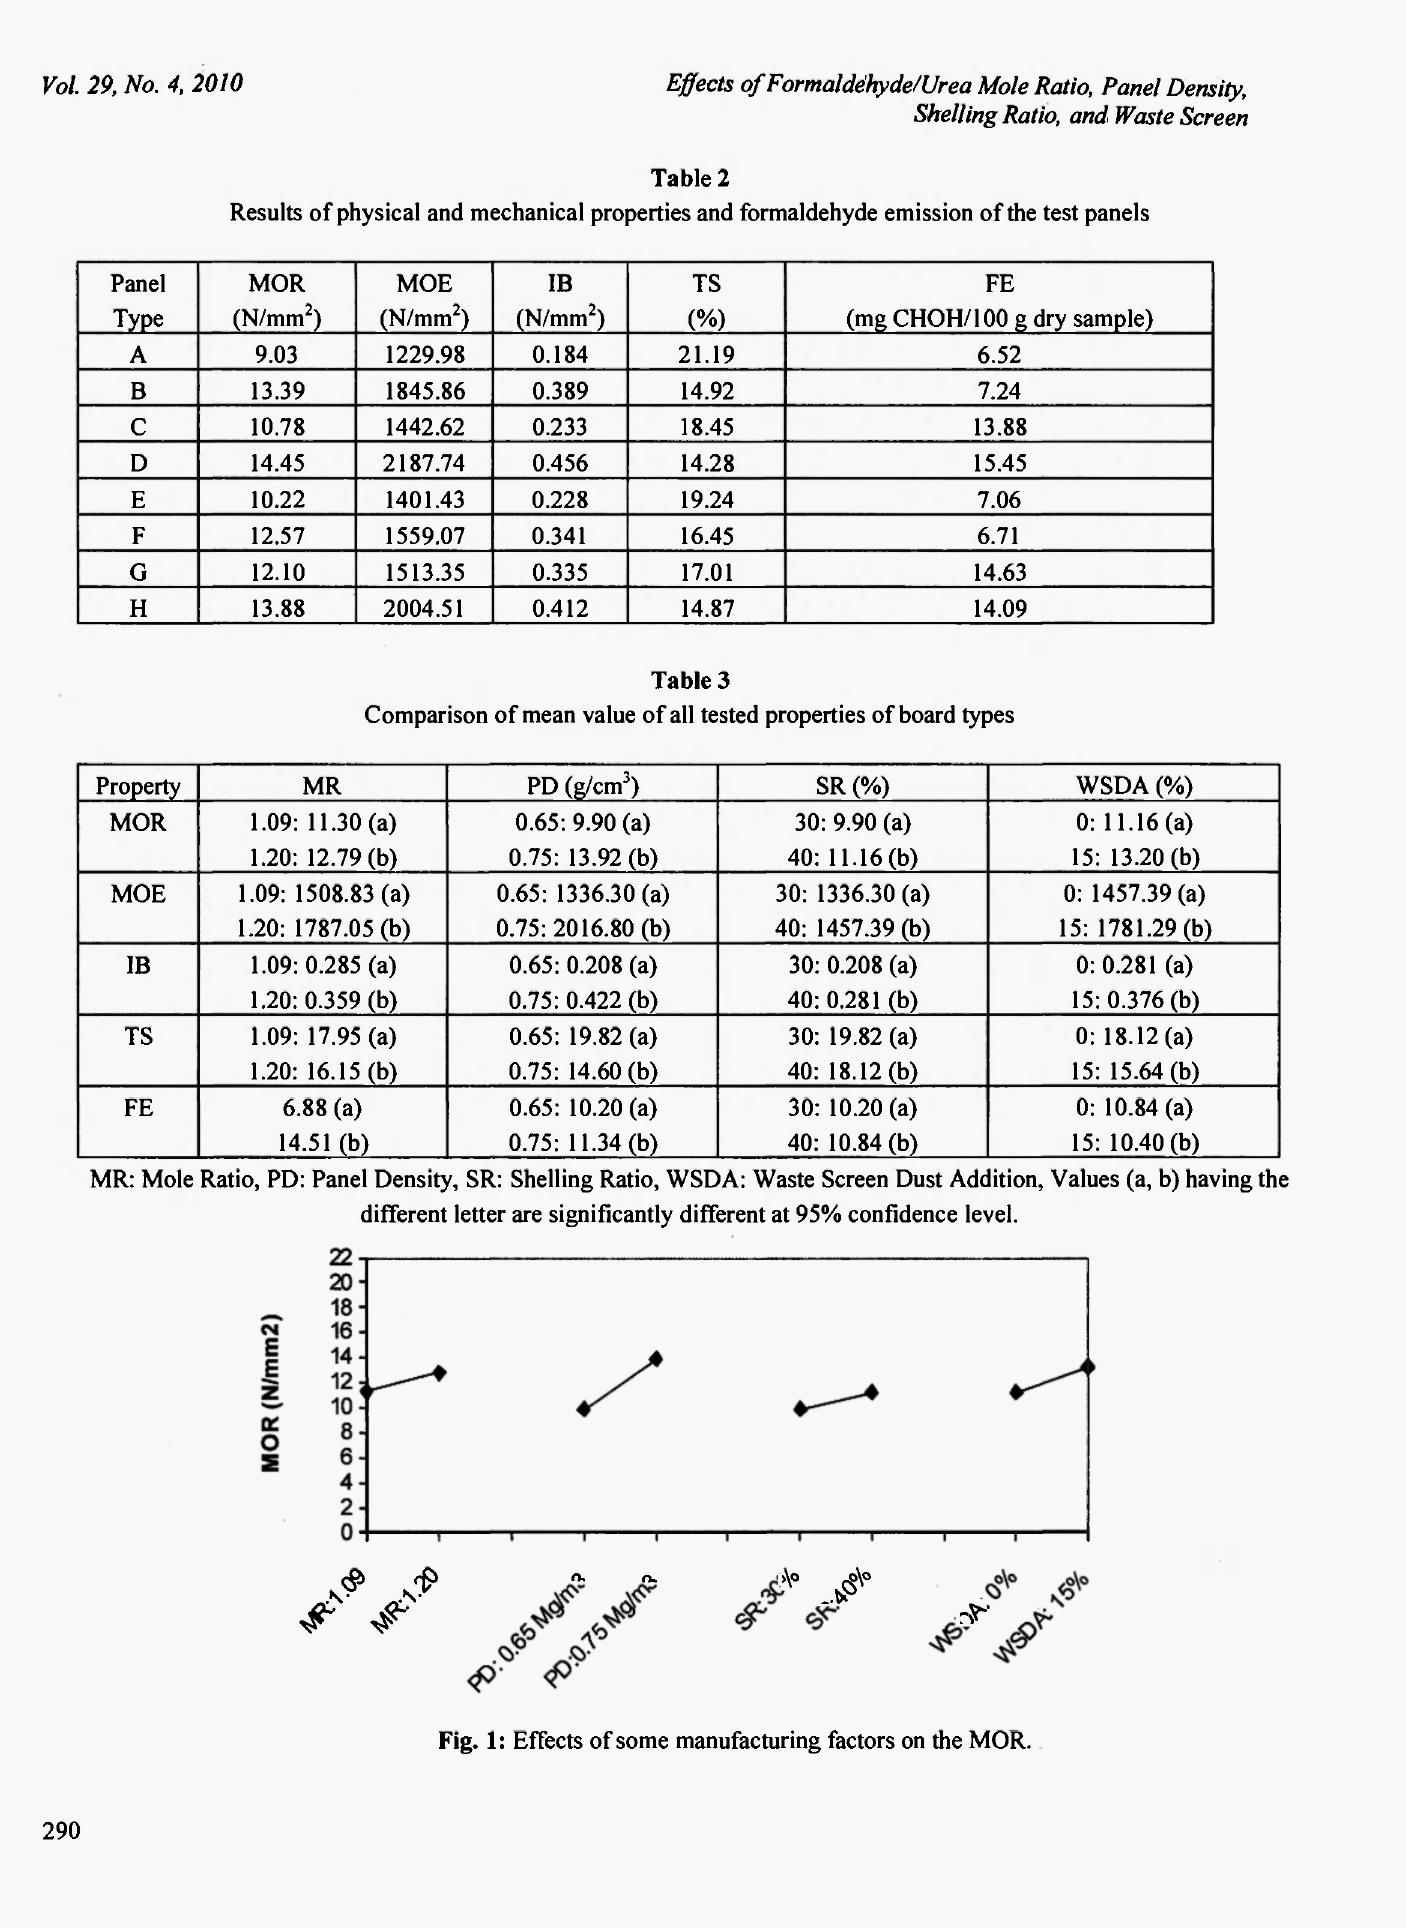
Fig. 1: Effects of some manufacturing factors on the